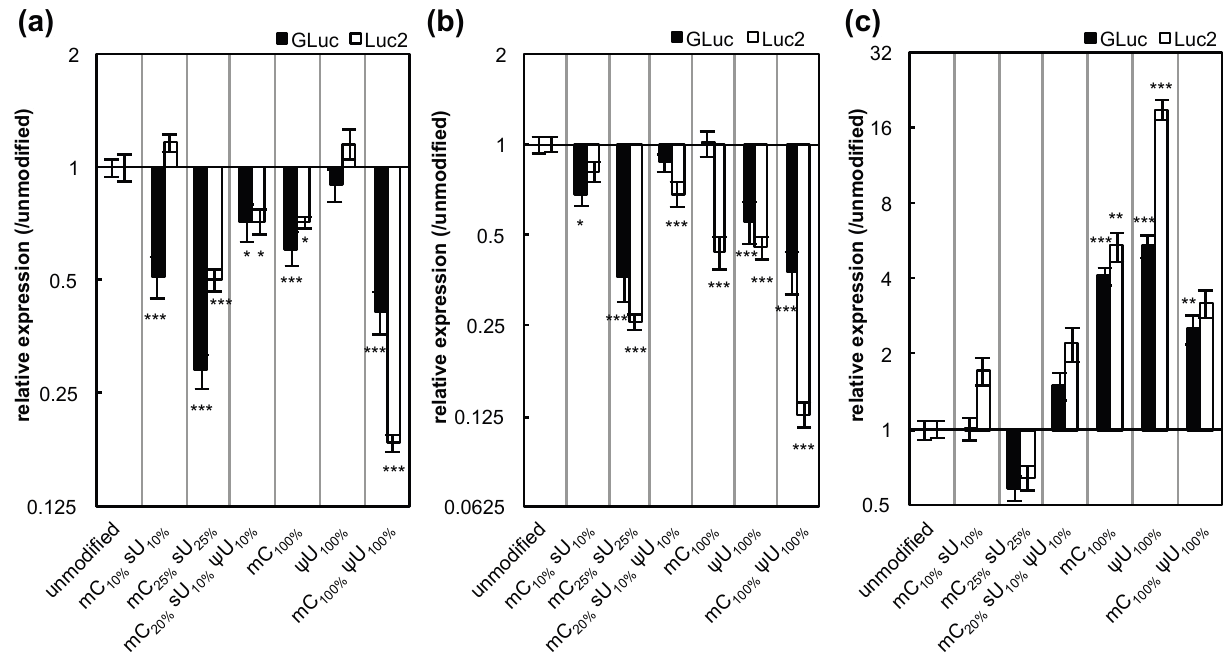
Figure 4. GLuc expression efficiency after mRNA introduction using two different transfection reagents. Two types of transfection reagents, Lipofectamine™ LTX (Lipo, black bars) and linear polyethyleneimine (LPEI, white bars), were used for mRNA introduction. mRNA-encoding GLuc was introduced to ( a ) HuH-7, ( b ) MEFs, and ( c ) MSCs. After 24 h, the amount of GLuc protein in culture media was measured. The graph shows relative values compared to GLuc expression after transfection of unmodified mRNA. For Lipo-treated groups, the same data shown in Figure 3 are presented. Data are presented as the mean ± standard error of the mean (S.E.M.) ( N = 6). Statistical significance was assessed by one-way analysis of variance (ANOVA) followed by Dunnett’s test. * p < 0.05, ** p < 0.01, *** p < 0.001 versus unmodified